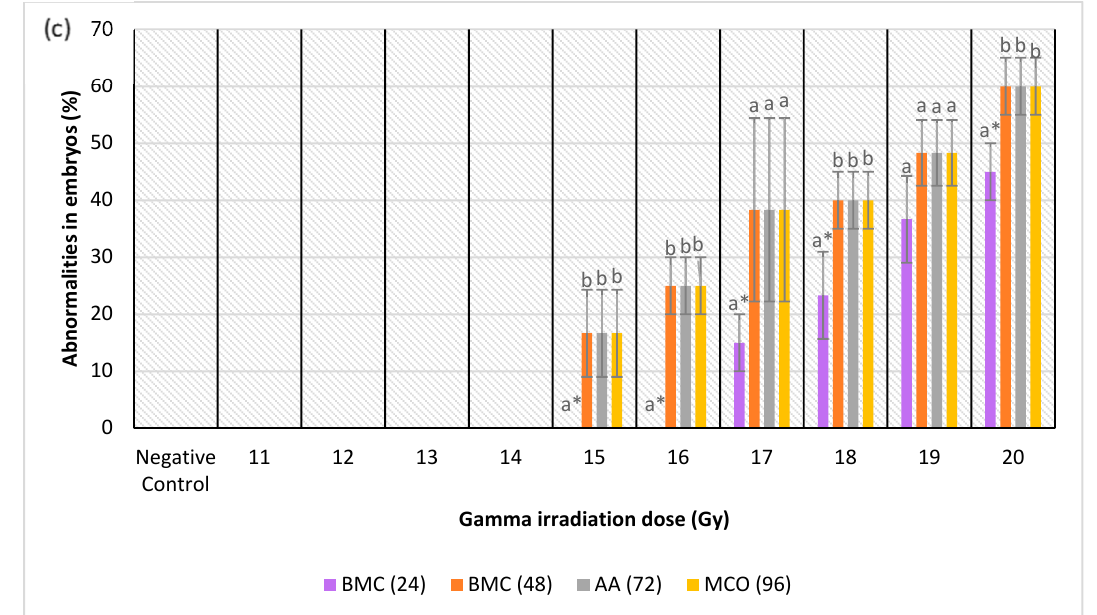
Figure 6. ( a ) Abnormalities produced for each dose in the irradiated zebrafish embryos in IN group; ( b ) abnormalities produced for each dose in the irradiated zebrafish embryos in IKH group; ( c ) abnormalities produced for each dose in the irradiated zebrafish embryos in IKH group. a*, b*, c* and d* indicate significant difference ( p < 0.05) compared to other abnormalities. a, b, c and bc indicate no significant difference ( p > 0.05) compared to other